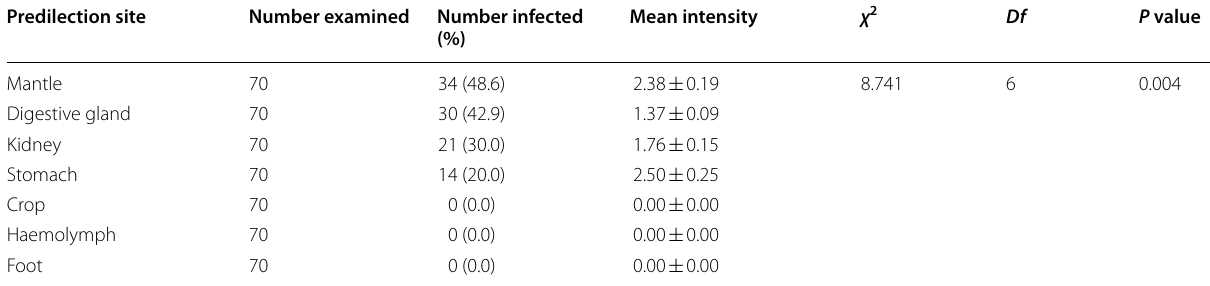
Table 3 Prevalence Angiostrongylus cantonensis among Archachatina marginata examined based on the predilection site of infection Predilection